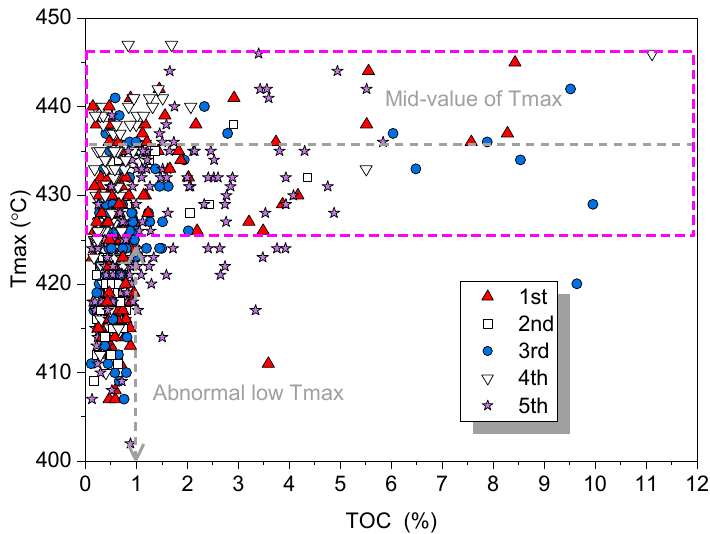
Figure 12. Tmax vs. TOC plot showing the existence of migrated hydrocarbons in the samples with TOC < 1%.